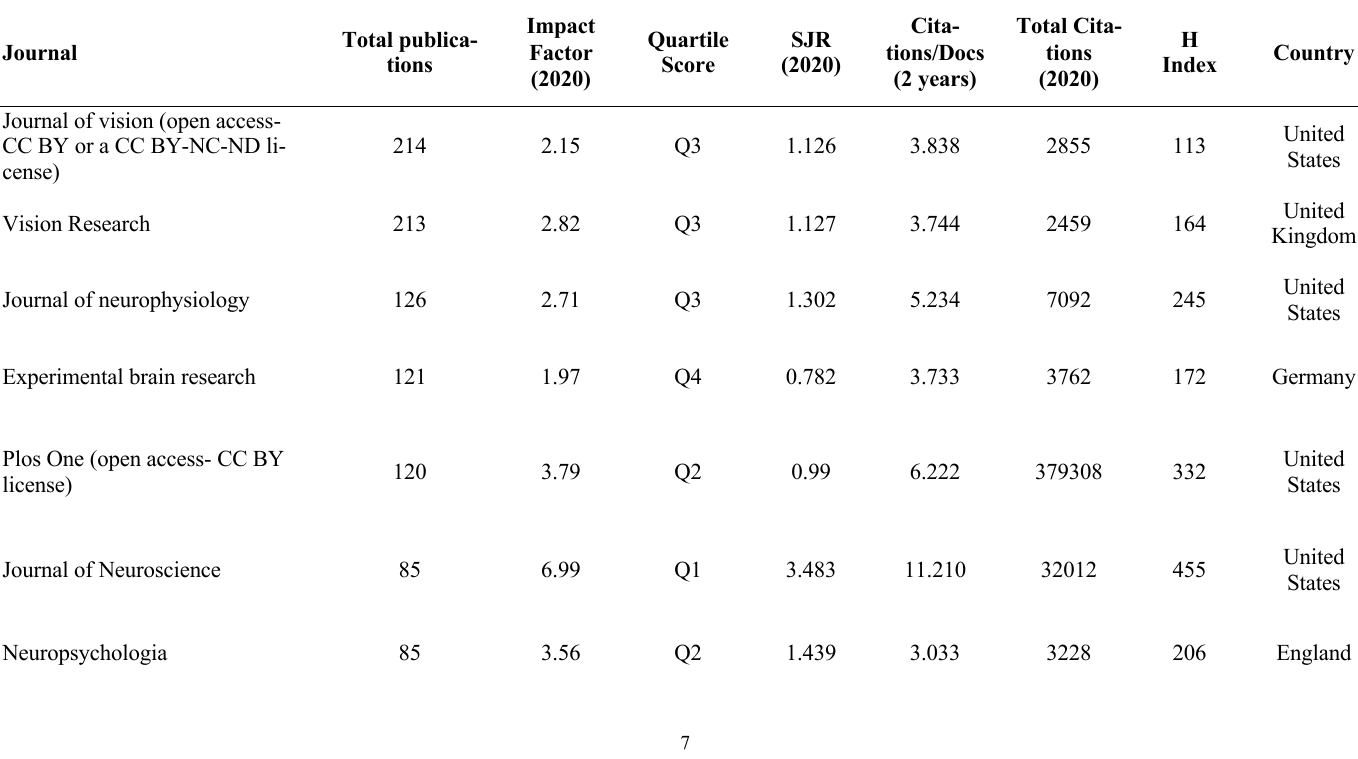
Table 5. Top 20 journals with the most